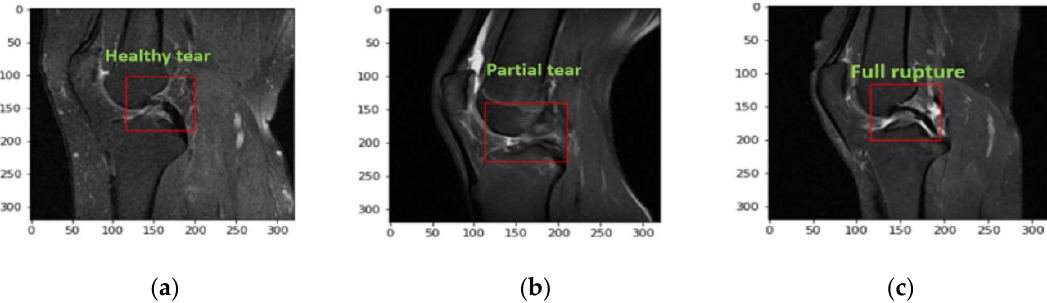
Figure 2. Samples of a healthy tear: ( a ) no changes in the length of an ACL tear, ( b ) sample of an ACL partial tear, ( c ) full rupture in an ACL tear.